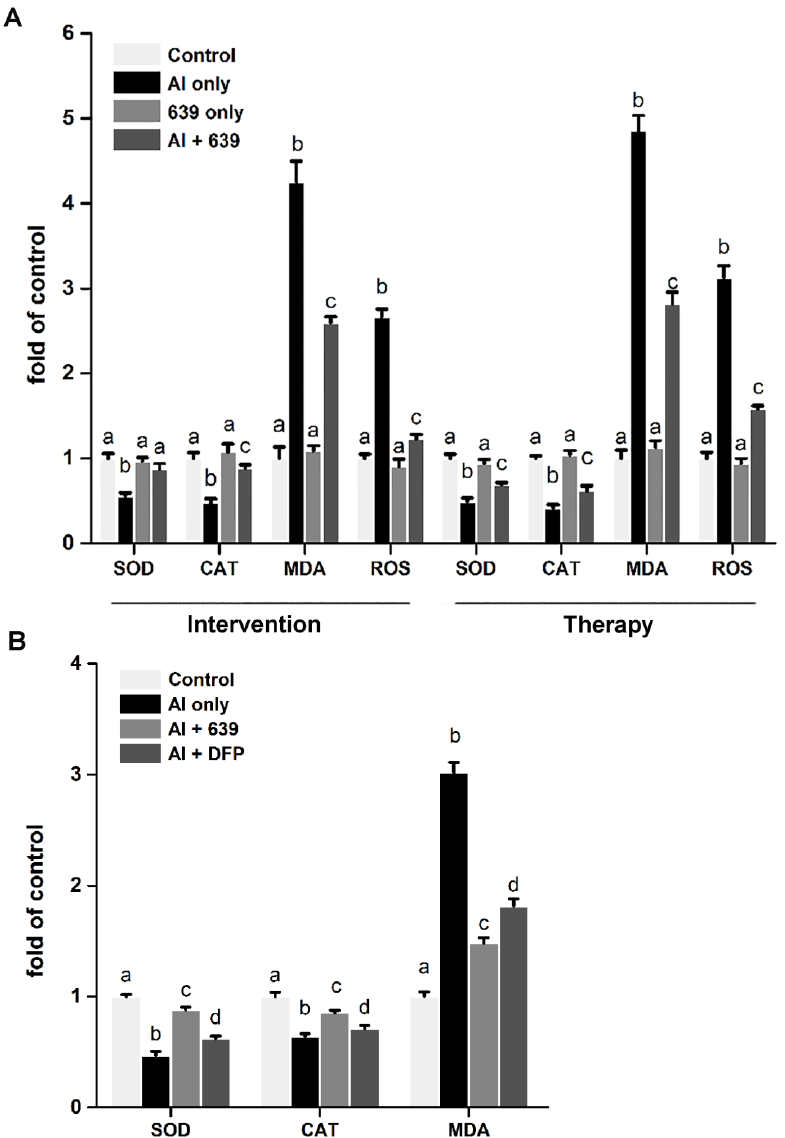
Figure 6. Effects of L. plantarum CCFM639 on Al-induced oxidative stress in HT-29 cells and serum of mice: ( A ) the activities of SOD and CAT and levels of MDA and ROS in HT-29 cells; and ( B ) the activities of SOD and CAT and MDA level in serum of mice. Values are expressed as fold change versus control group and presented as the mean ± SEM. The different letters a–d indicate statistically significant changes among four groups ( p < 0.05).